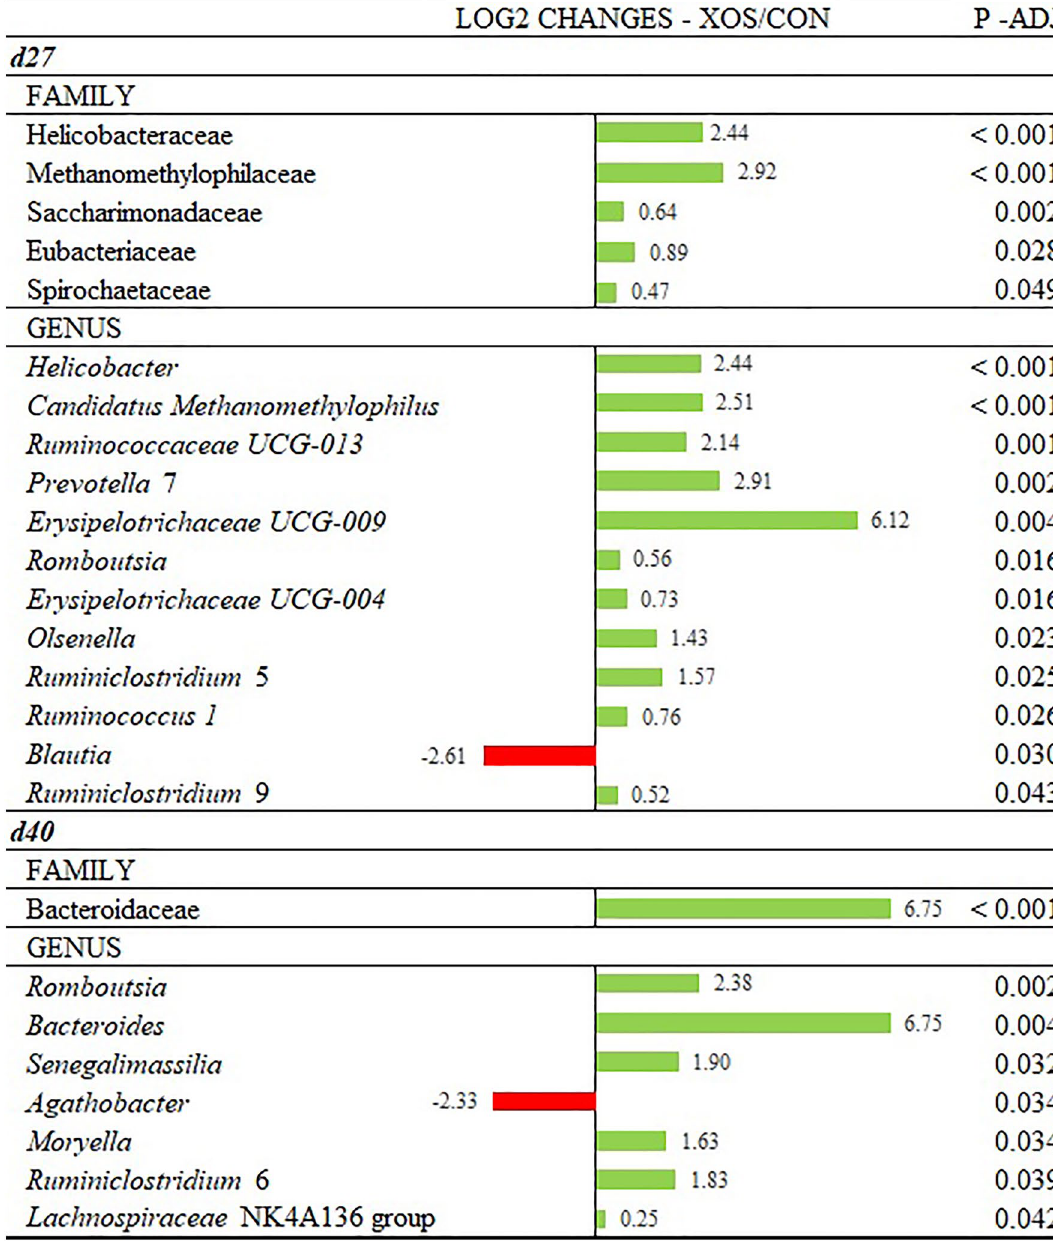
Figure 3. Log 2 changes promoted by xylo-oligosacharides supplementation (fold discovery rate p-adjusted < 0.05) in microbial families and genera on d27 and d40. Taxa are sorted by level of significance (from higher to lower). Differences presented are based on all taxa detected in samples per